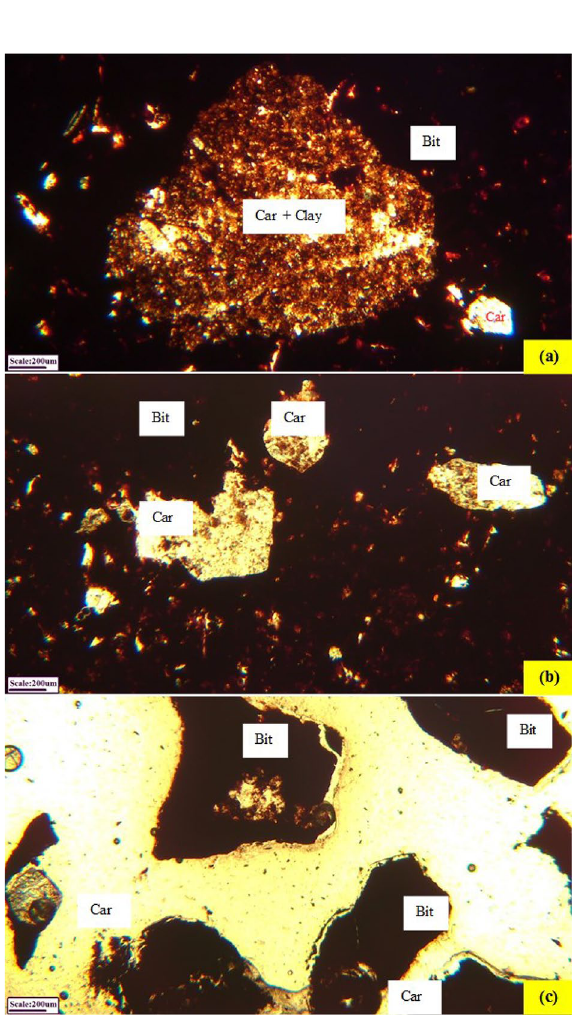
Figure 2. Distribution and abundance of gangue minerals with bitumen in the size fraction of ( a ) coarse particles (+ 3 mm), ( b ) medium size (+ 0.5 − 3 mm) and ( c ) fine particles (− 1 mm)—[bitumen (Bit), carbonate (Car), clay (clay)]—microphotographs in plane polarized light